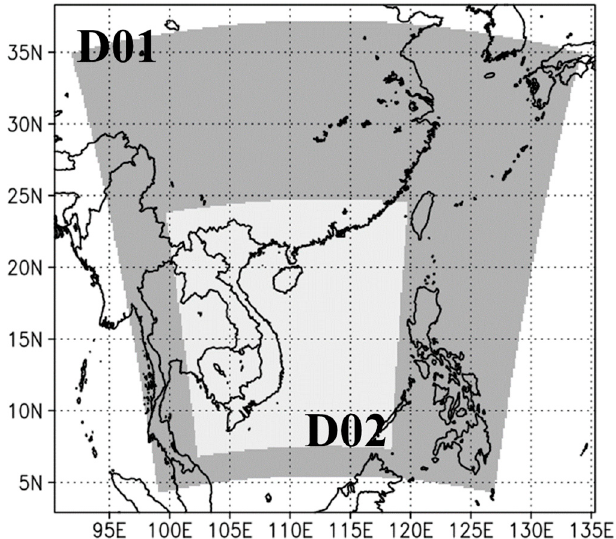
Figure 2. Target domains of downscaling in the Weather Research and Forecasting (WRF) model. The spatial resolutions are 30 km and 10 km for D01 and D02, respectively.